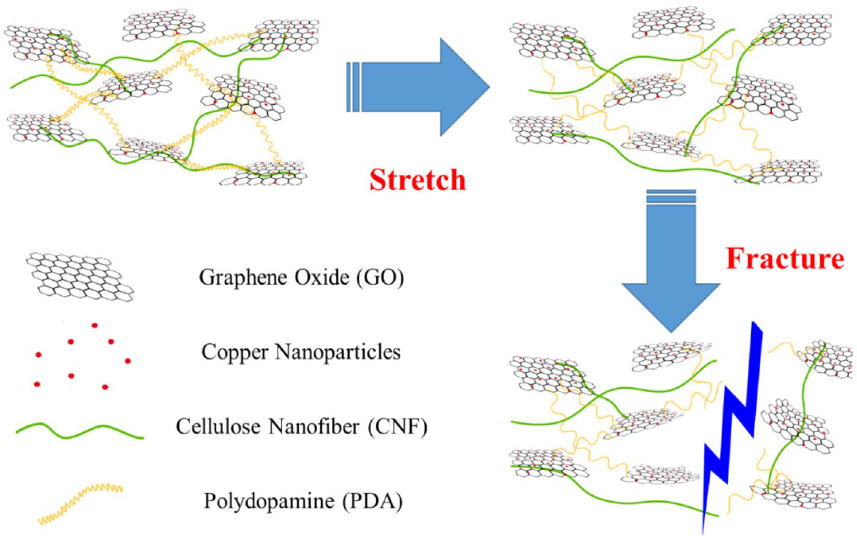
Figure 13. Proposed synergistic mechanism of ternary P-GCP artificial